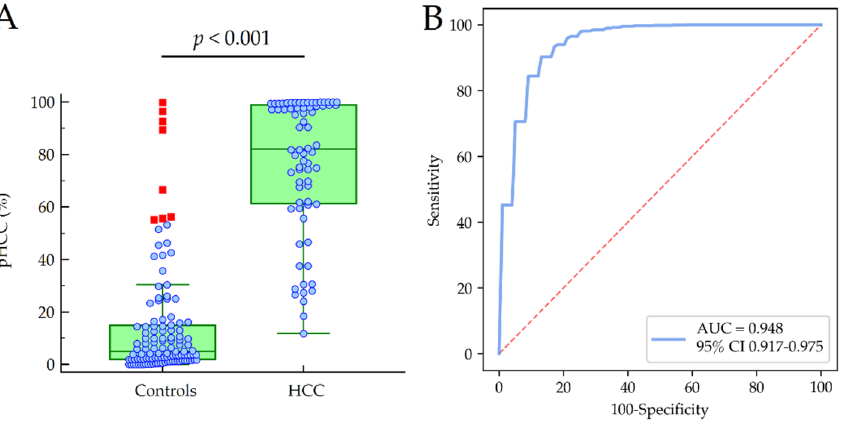
Figure 4. Median values of pHCC in patients with and without HCC ( A ) and diagnostic accuracy of the model ( B ). Red squares indicate values that are larger than the upper quartile plus 3 times the interquartile range. p -values were calculated by the Mann–Whitney test. Abbreviations: area under the curve (AUC), confidence interval (CI), hepatocellular carcinoma (HCC) and probability of hepatocellular carcinoma (pHCC).